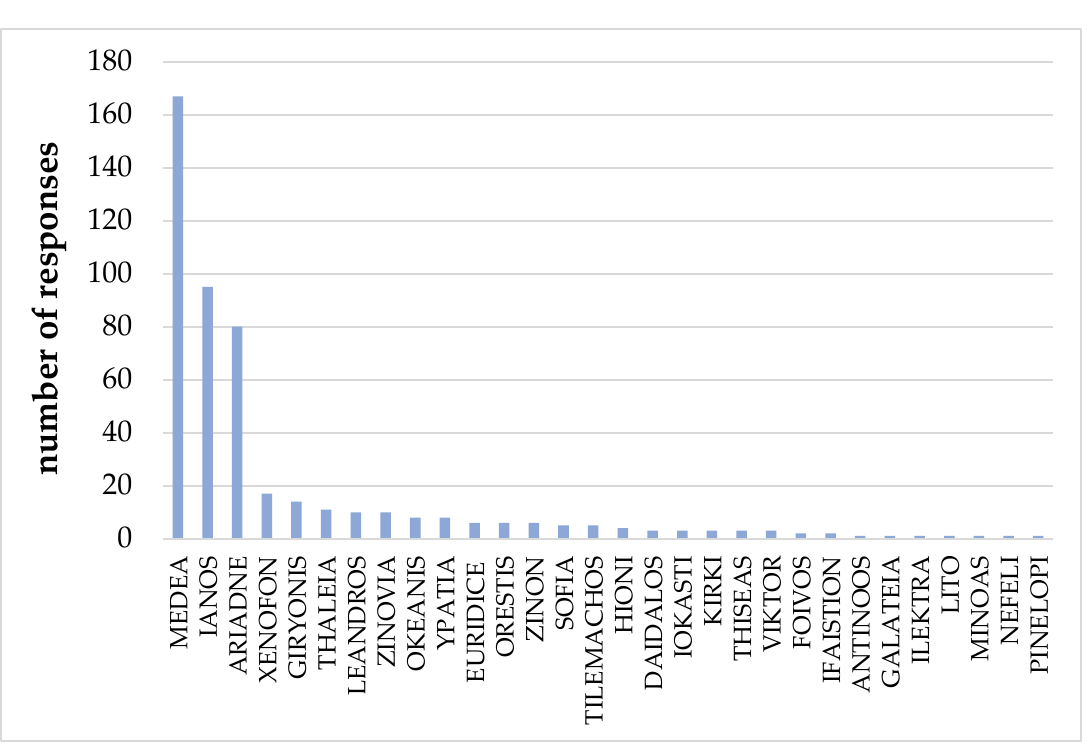
Figure 8. Ranking of the named storms by their impact based on the respondents to the questionnaire.